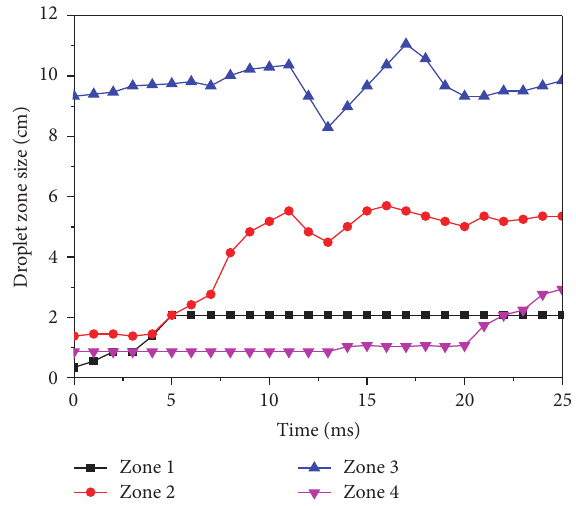
Figure 5: Change of droplet zone size in the expansion process. from the stable breakup front to the surface of water. The blue dashed lines in Figure 6 are the auxiliary lines used to ascertain the terminal speed and breakup length. Manual error is introduced during the determination of the terminal speed, which we found to be within 5% after verifying the results of different